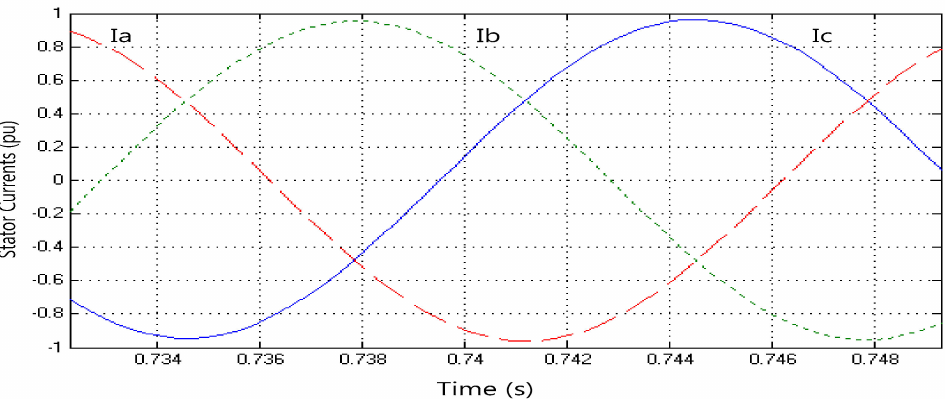
Figure 9. Stator phase current.